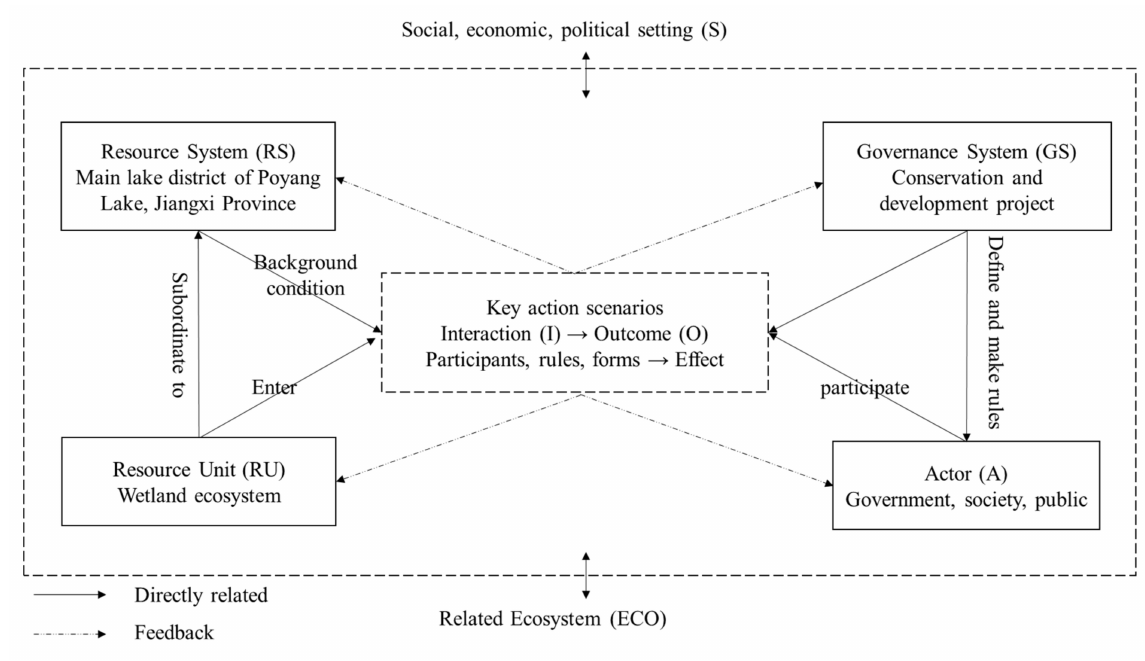
Figure 2. Framework of social-ecosystem system (SES)